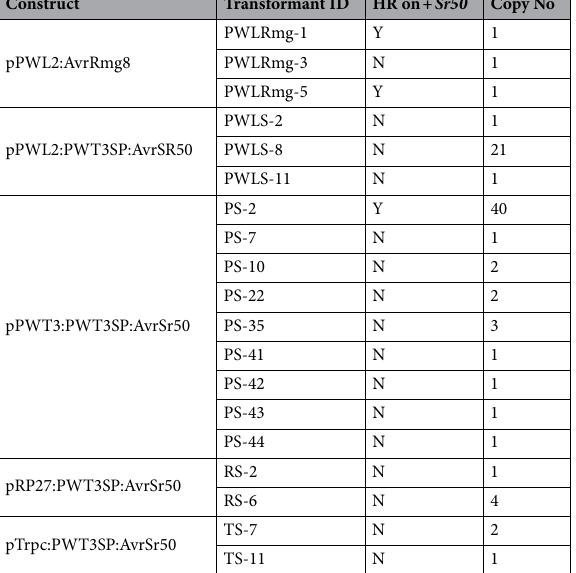
Table 1. Transgene copy number of MoT transformants. Copy number analysis of transgenes was performed by iDNA genetics (Norwich, UK) using a TaqMan real-time PCR assay and a probe to detect the bialaphos resistance gene. HR hypersensitive